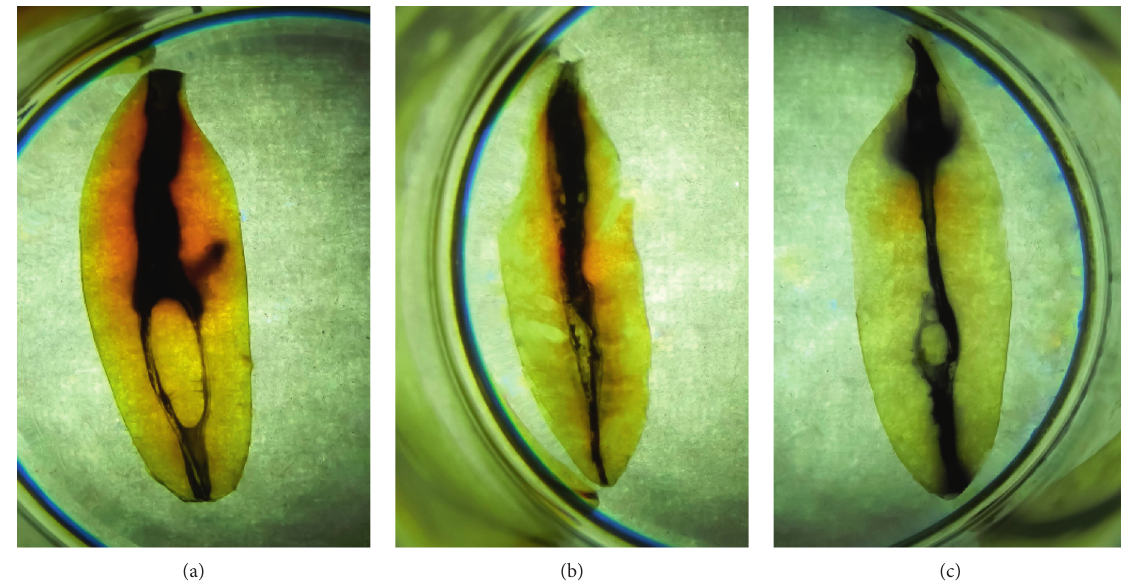
Figure 2: Three types of intercanal calcification: fusiform, islet, and